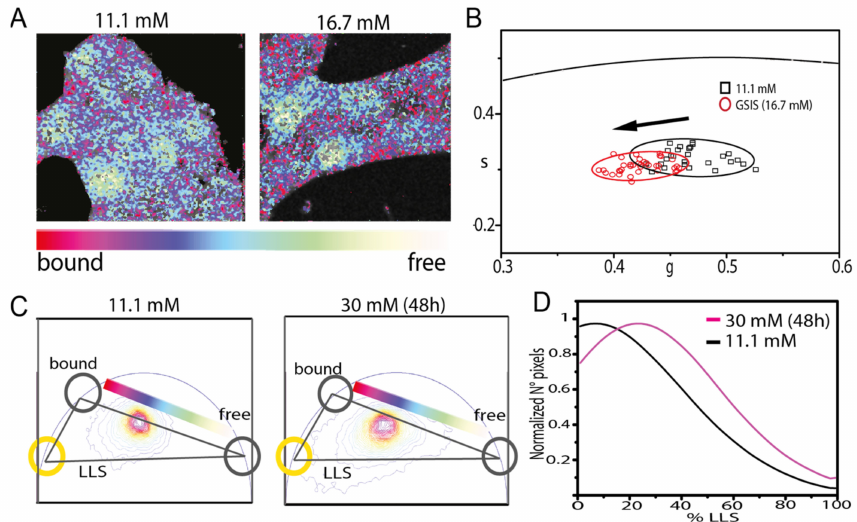
Figure 4. Phasor-FLIM analysis on INS-1E cells. ( A ) Example images of NAD(P)H lifetime (bound and free) in INS-1E cells in 11.1mM and 16.7 mM glucose, colored in accordance with the color bar defined below. ( B ) Scatter plot of the average values of distinct phasor distributions, each relative to distinct acquired cells. Black squares represent cells in maintenance condition, and red circles stimulated cells. ( C ) Three components analysis on phasor plot of cells cultured in 11.1 mM glucose and exposed to high glucose medium for 48 h. ( D ) Resultant graph from three components analysis, in which percentage of LLS species is plotted vs the number of pixels and long lifetime species are present for the aforementioned conditions. LLS, long lifetime species. GSIS, glucose stimulated insulin secretion (16.7 mM glucose). Adapted from Ferri et al. [28].